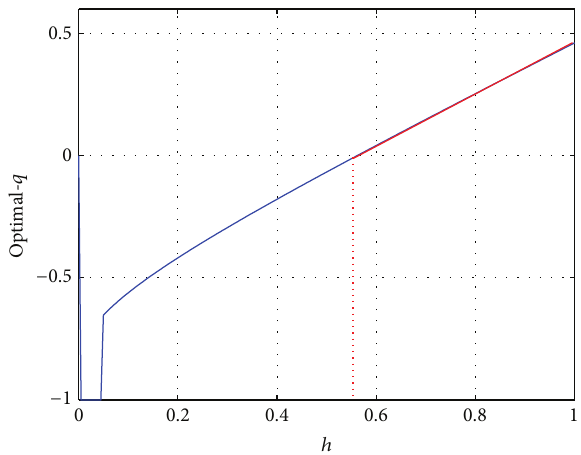
Figure 1: The optimal estimation of fractional order 𝑞 in (12).